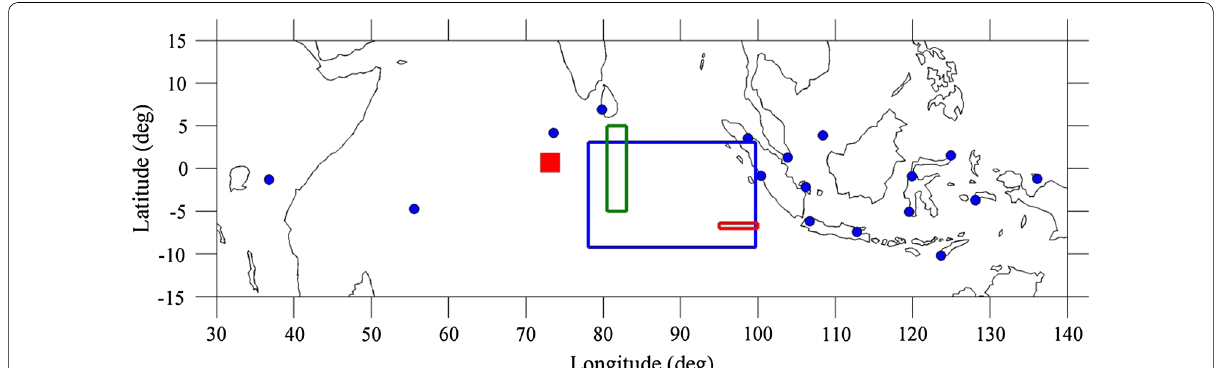
Fig. 2 Location of the radiosonde launch stations during the CINDY-DYNAMO 2011 project. Blue dots denote sites with 12-h launch cycles. Red square indicates Gan Island. Blue, green and red boxes are the cruising area of Mirai, Sagar Kanya and Baruna Jaya research vessels (R/V),